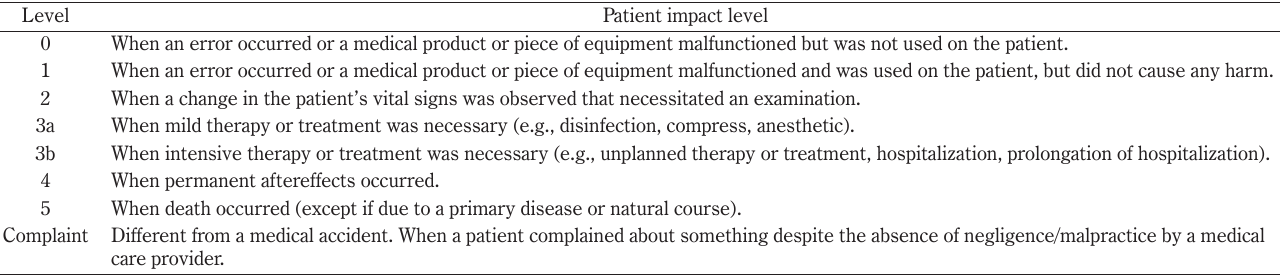
Table 1 Medical accident level categories Level Patient impact